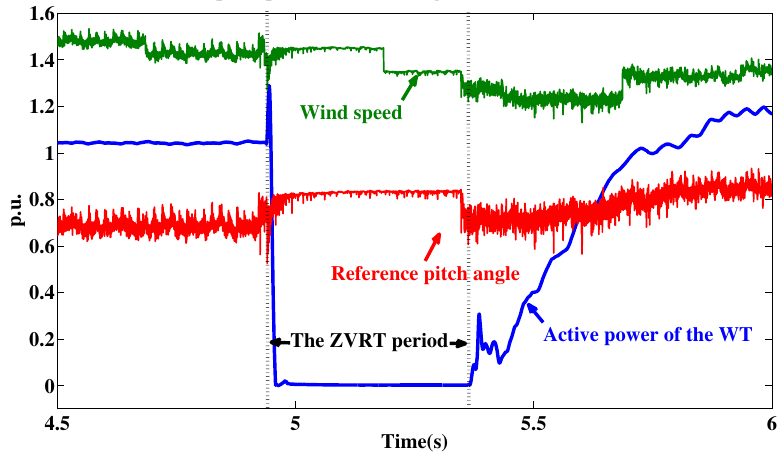
Figure 20. Results of the field test. The p.u. values of the reference pitch angle, active power, and wind speed are 10 ◦ , 2 MW and 10 m/s, respectively. The fault condition is a three-phase (symmetrical) voltage